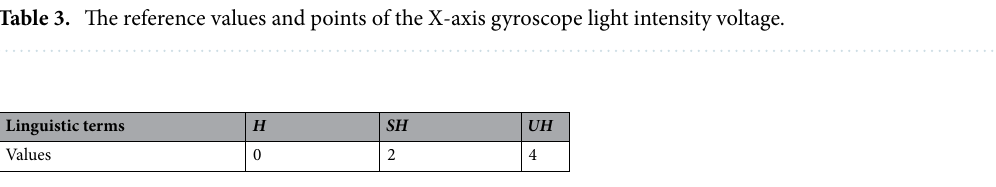
Table 4. The reference values and points of laser gyroscope health